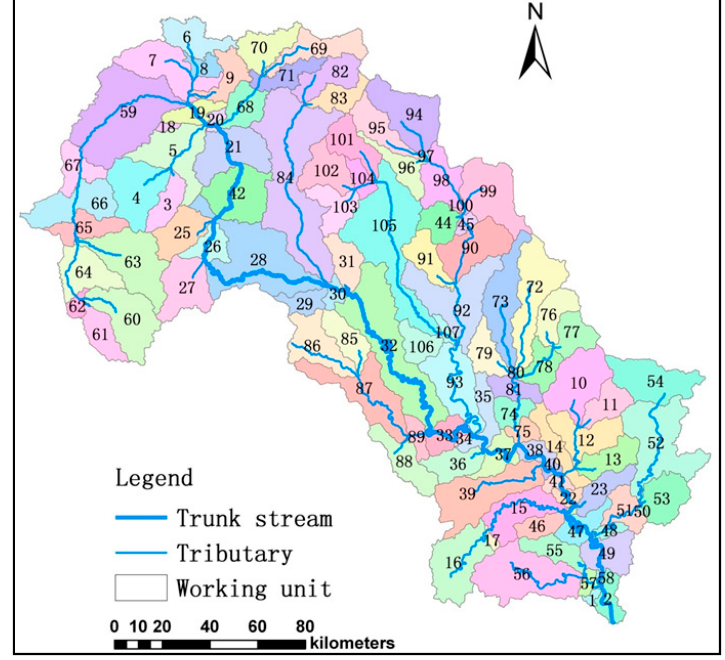
Figure 4. Working unit partition map in upper-middle reaches of Luanhe River.